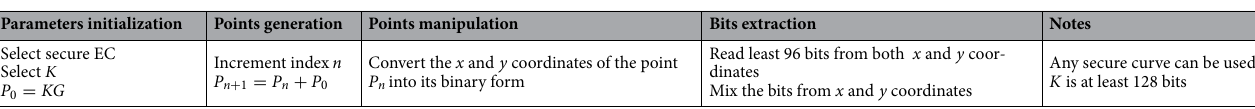
Figure 6. Simplified block diagram for the proposed PRNG .